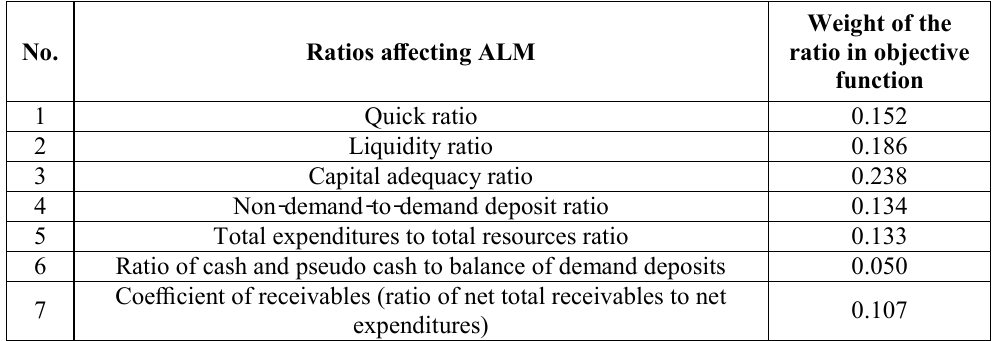
Table 1. Weights of the ratios affecting